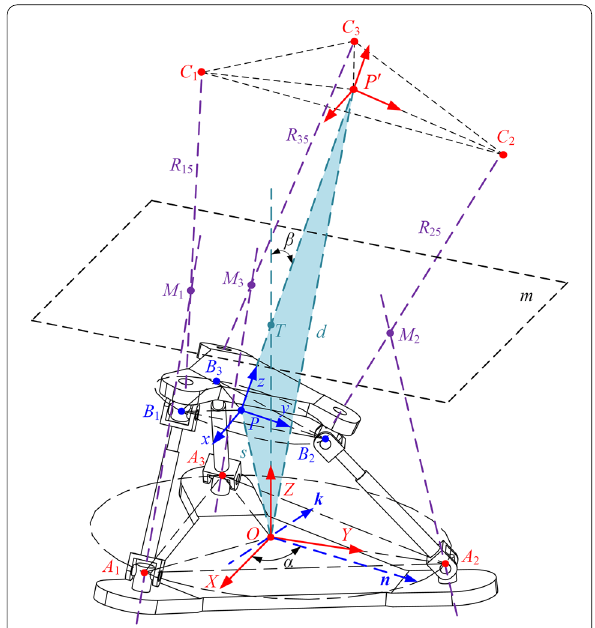
Figure 2 Inverse kinematics of M-RCM